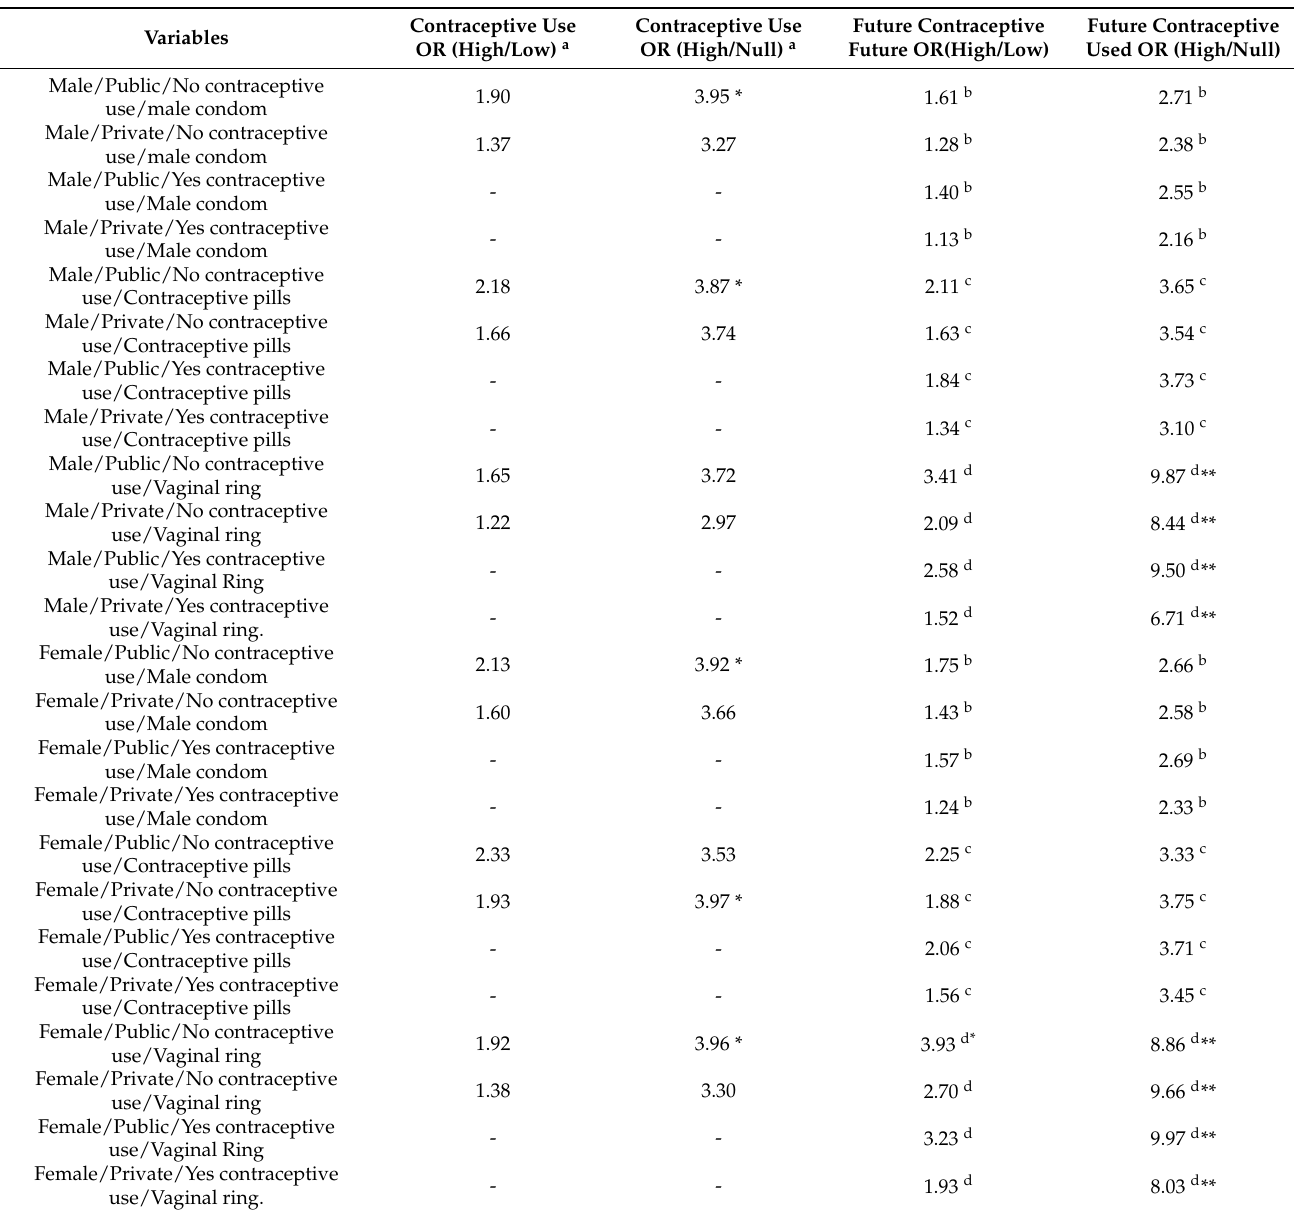
Table 5. Estimated odds ratio for the variables contraceptive use during first sexual experience and contraceptive method of future